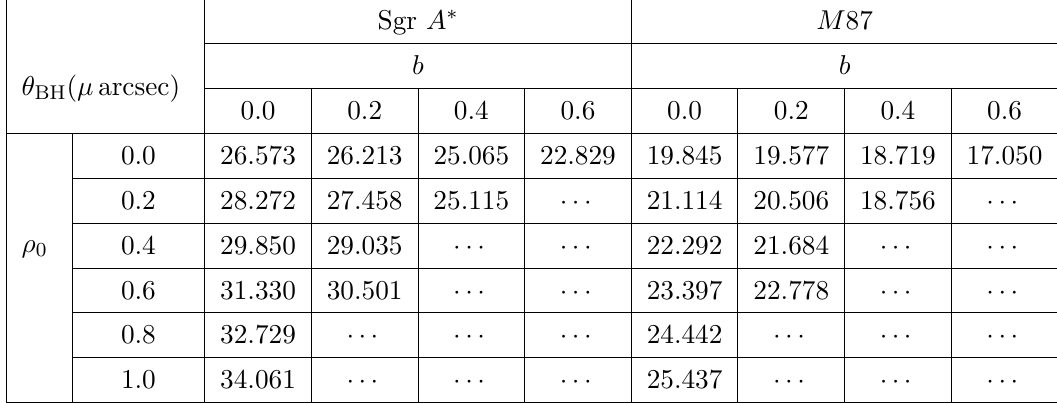
Table 1 . The numerical estimation for the angular radius of the black shadow for the supermassive black hole Sgr A* in our Galaxy and the black hole in M 87 by using the metric of a rotating squashed KK black